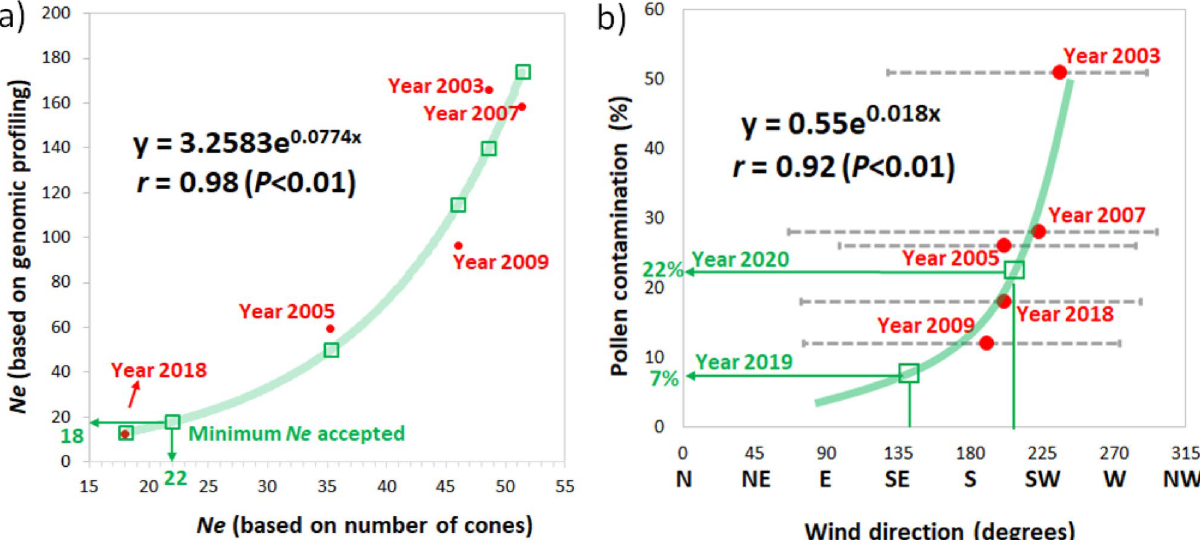
Figure 4. Correlation plots (Pearson’s) showing exponential trendlines (green lines), equations, R-squared values and P values for different traits. ( a ) Effective population size ( N e ) calculated using the number of cones per genotype versus using genomic profiles; ( b ) Pollen contamination levels (%) estimated using SNP profiling versus wind direction average between 15 and 31 May of each year. Red dots show data used for fitting the equations. Green squares show predicted values using the equations. Grey dotted lines indicate all values, including maximum and minimum wind speed values. Weather data for 2003–2018 was obtained from www. clima te.weath er.gc.ca, and for 2019–2020 was obtained from www.acis.alber ta.ca. The “Minimum N e accepted” corresponds to the value suggested in the Alberta forestry policies, which is N e = 18 8